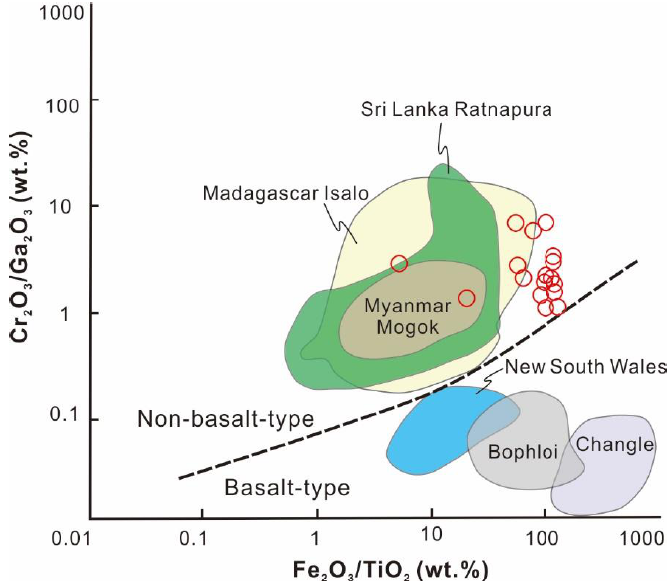
Figure 4. Cr 2 O 3 /Ga 2 O 3 versus Fe 2 O 3 /TiO 2 ratios of the Fuping color-change sapphires as well as blue sapphires from other major gem-producing countries [39]. The data of the Fuping color-change sapphires in China are shown with red circles. The dashed line is the boundary between basalt-type and non-basalt-type sapphires.